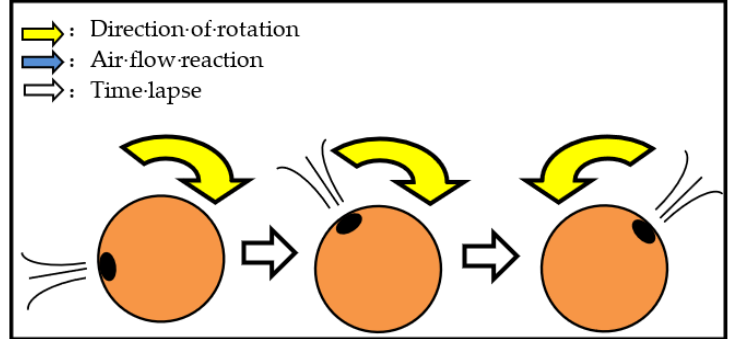
Figure 11. Change in hole and direction of movement to rotation.